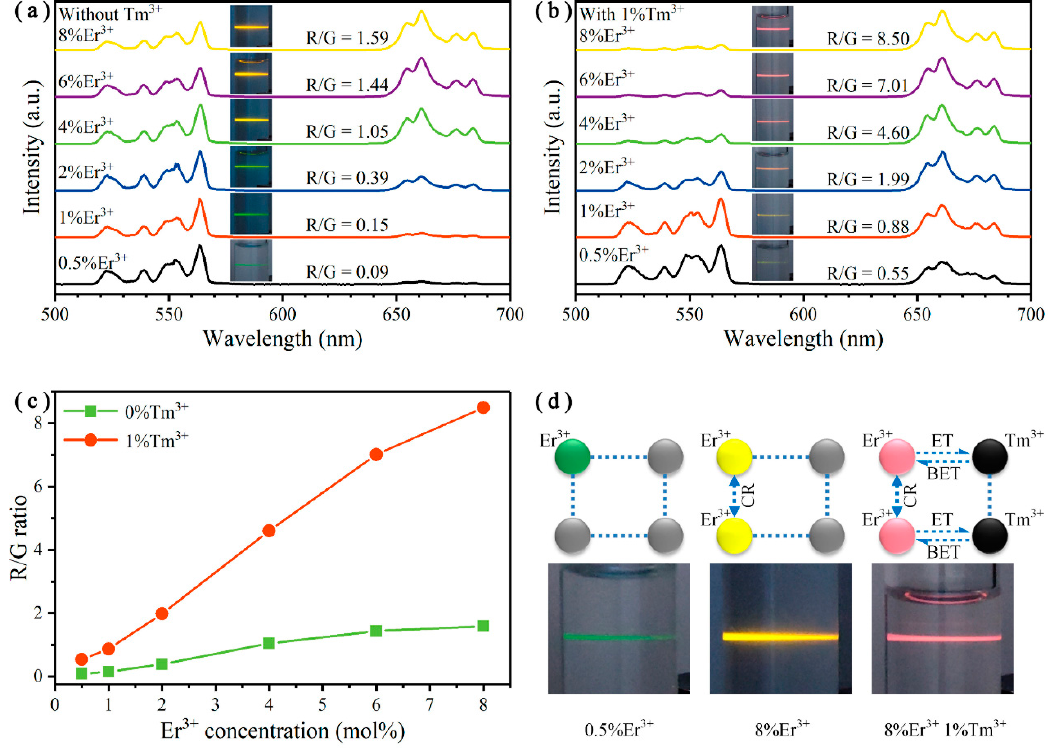
Figure 4. Normalized UC emission spectra of Y 2 O 3 :Er 3 + / Tm 3 + ( x / y mol%) UCNPs, x = 0.5, 1, 2, 4, 6, 8, ( a ) y = 0, ( b ) y = 1. ( c ) R / G ratios of the Y 2 O 3 :Er 3 + / Tm 3 + UCNPs doped with di ff erent concentrations of Er 3 + and Tm 3 + ions. ( d ) Simplified cross-relaxation (CR), energy transfer (ET) and back energy transfer (BET) mechanism. All excited by a 980 nm laser at an excitation intensity of 341 W cm − 2 .